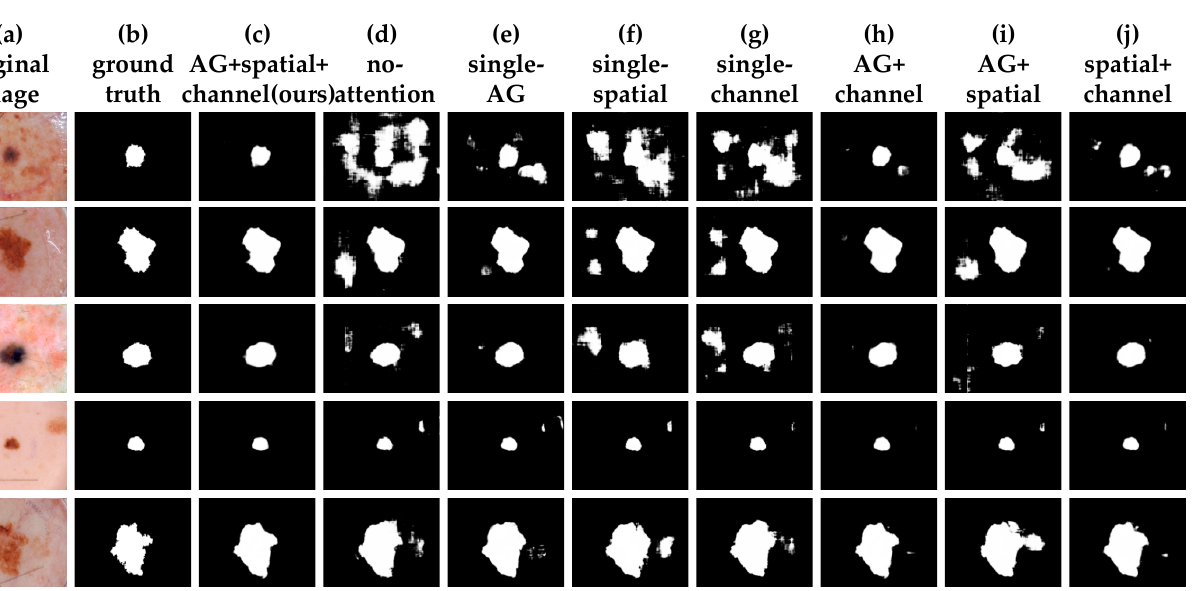
Table 5. Performance comparison of different attentional mechanisms on the ISIC-2017 dataset.